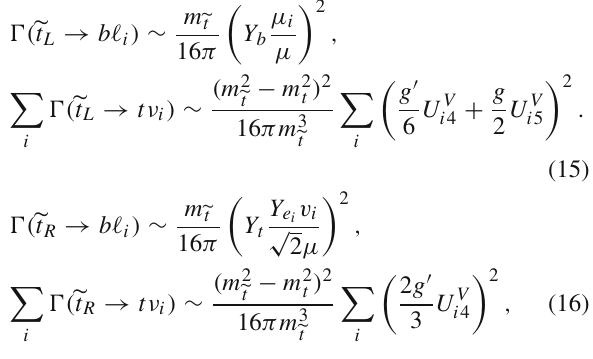
Fig. 1 δ m 2 = m 2 (left panel) neutrino Yukawas and (right panel) left sneutrino VEVs. Colors blue, green and grey correspond to i = 1 , 2 , 3,